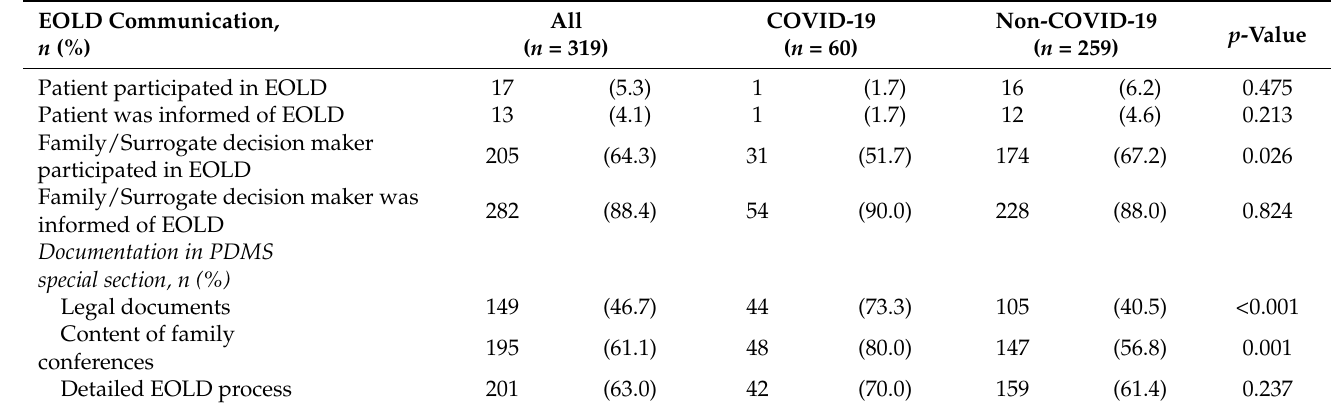
Table 5. EOLD communication and documentation in patients deceased with